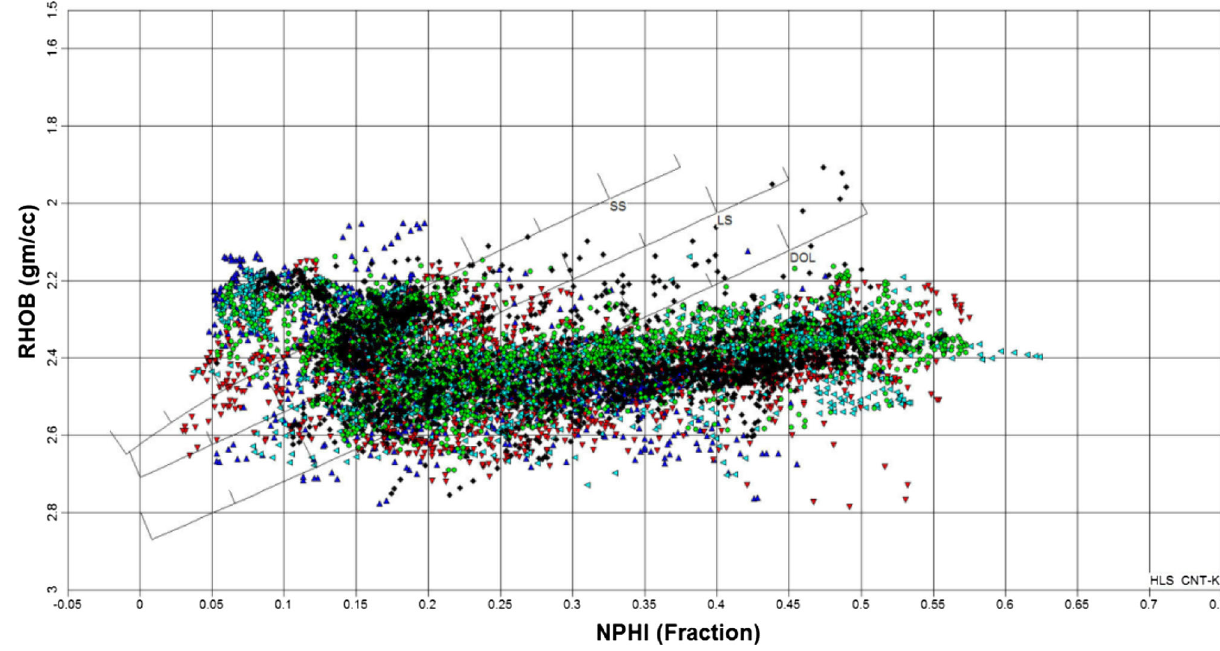
Fig. 8 Multi-well conditioned RHOB versus NPHI cross-plot to test the consistency of